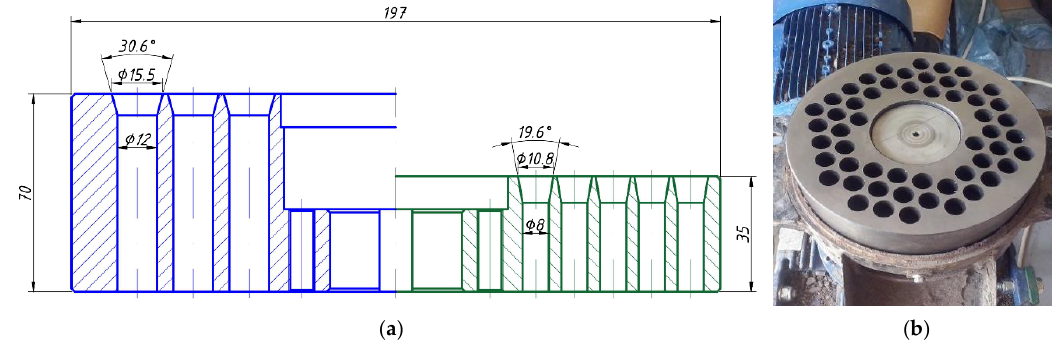
Figure 15. ( a ) Modified die (blue) compared to standard biomass die (green), and ( b ) modified die mounted into the pelletiser.